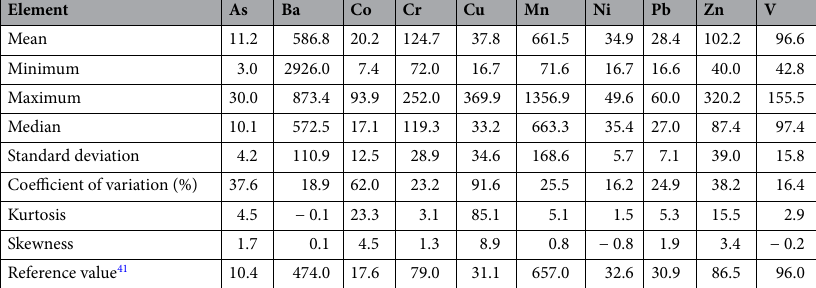
Table 1. Contents of HMs and background values in topsoil of Sichuan (mg kg −1 ).